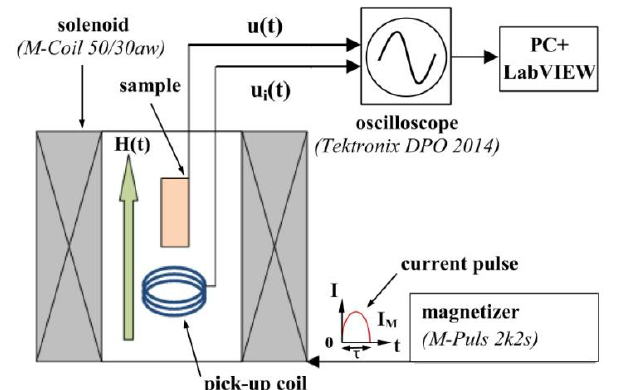
Figure 2. Schematic diagram of the measurement